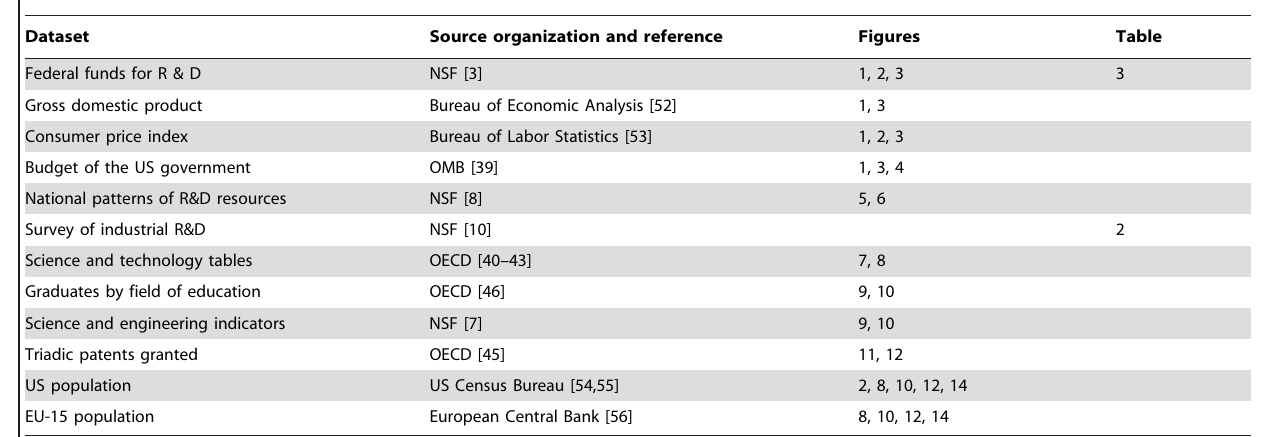
Table 1. Datasets used in the